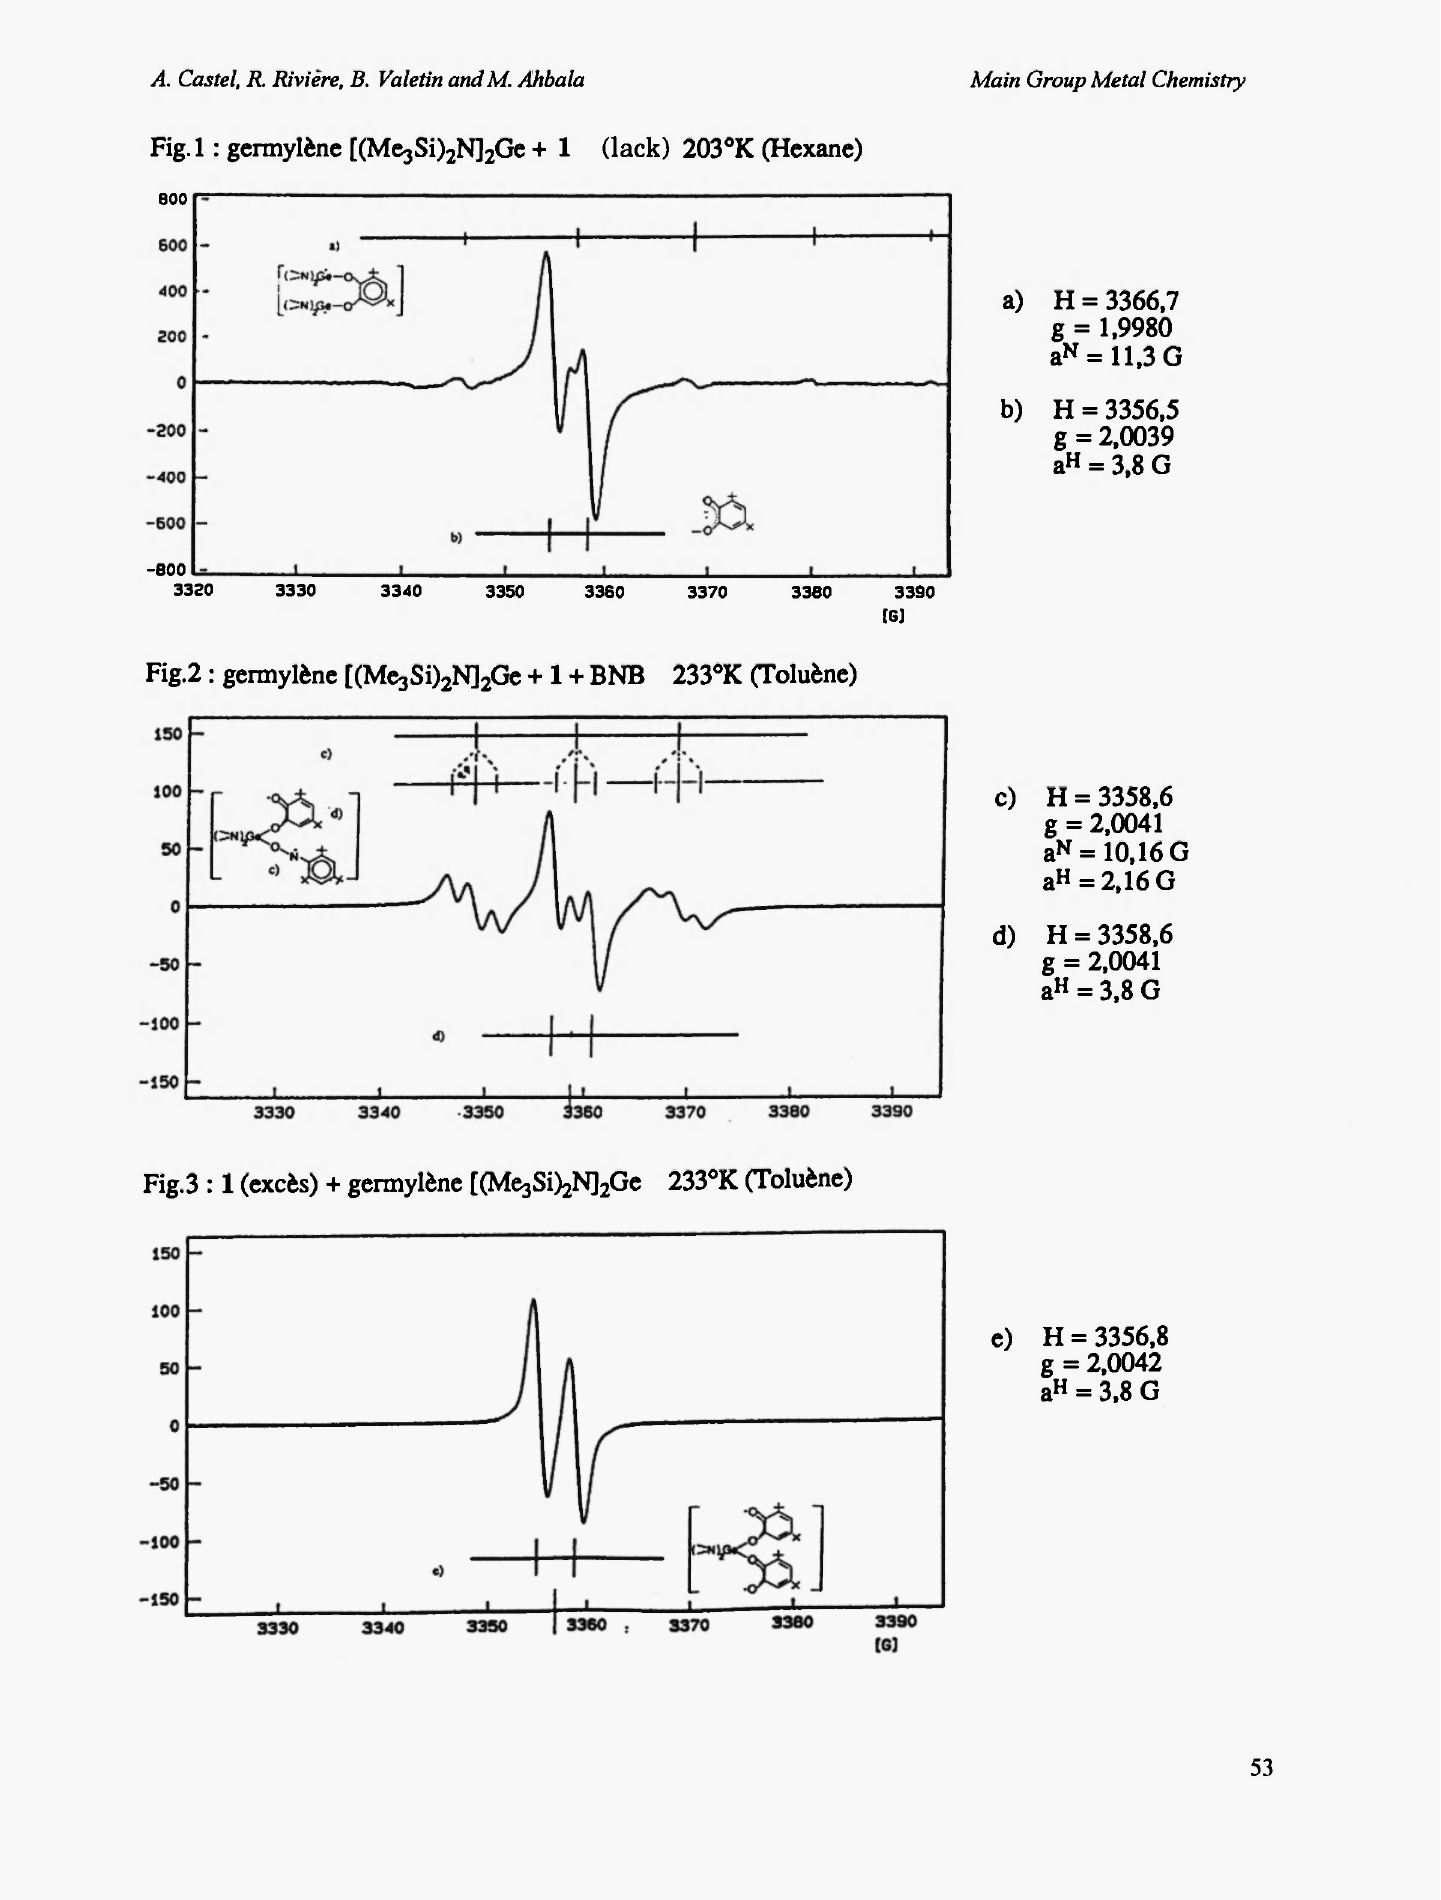
Fig.3 :1 (excfcs) + g e r m y l ö ne [ ( M ^ S i ^ N ^